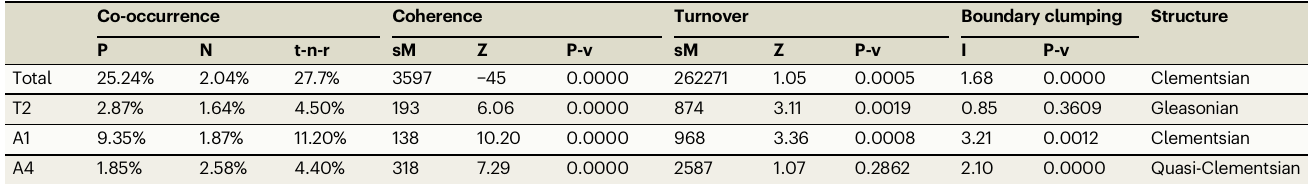
Table 1 | Metacommunity metrics of co-occurrence, coherence, turnover and boundary clumping, and overall structure type, for the total archaeocyaths species on the Siberian Platform, and metacommunities from the Tommotian 2 (T2), Atdabanian 1 (A1) and Atdabanian 4 (A4) Co-occurrence